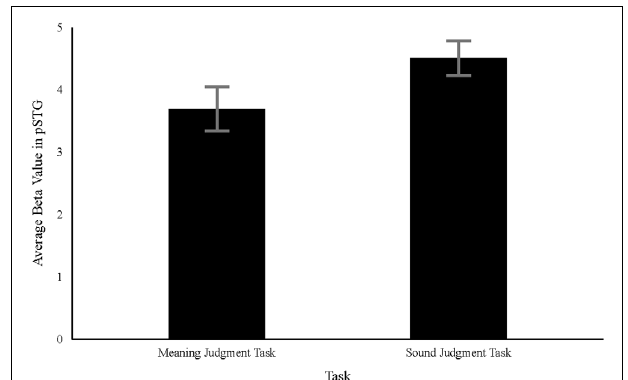
FIGURE 4 | The average beta value within the posterior superior temporal gyrus (pSTG) associated with the Meaning Judgment task [(High and Low) − Control] and the Sound Judgment task [(Rhyme and Onset) − Control]. Error bars depict the standard error of the